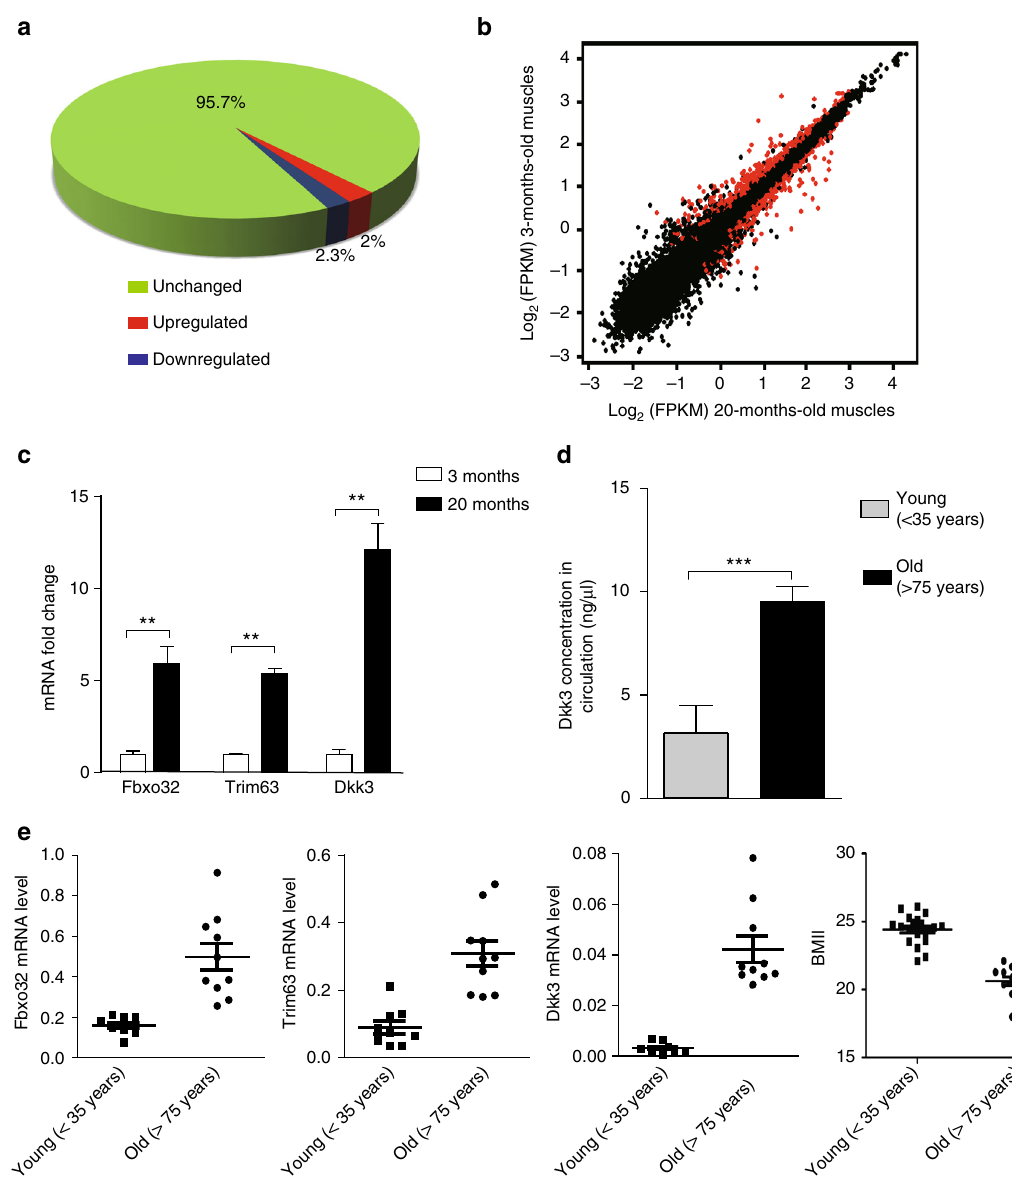
Fig. 1 Dkk3 is upregulated in muscles with age-related atrophy. a A pie diagram indicating the percentage of genes showing expression level changes in old versus young muscles. RNA was isolated from TA muscles showing atrophy and subjected for mRNA-sequencing analysis. The percentage of genes downregulated in TA muscles isolated from old mice compared to that in TA muscle isolated from young mice was indicated by blue. The percentage of genes upregulated in old TA muscles was indicated by red. The percentage of genes unchanged was indicated by green. b A scatter plot showing the comparison of transcriptome of old muscles showing atrophy versus young muscles. The red dots indicated the genes that were differentially expressed in old muscles versus young muscles. Statistic analysis was based on two independent mRNA-seq experiments for each sample. c Expression levels of Fbxo32 , Trim63 , and Dkk3 in primary myo fi bers isolated from young or old mice, respectively. RT-qPCR was performed with RNA extracted from the primary myo fi bers. Error bars indicated standard deviation (s.d.) and were based on three independent experiments. ** indicated p < 0.01. d Dkk3 protein level was elevated in peripheral blood of sarcopenia patients. Dkk3 protein level was examined by ELISA in blood samples taken from sarcopenia patients and healthy young humans. Error bars indicated s.d. and were based on 20 samples. *** indicated p < 0.001. e Dkk3 expression level was correlated with Fbxo32 and Trim63 expression level and BMI (body mass index) in aged human muscles. RT-qPCR assays were performed with muscle biopsies obtained from young or old patients and the results were normalized to GAPDH. The line indicated mean value. Error bars indicated s.d. and were based on 10 biological replicas. All p- values were based on two-tailed t- of myotubes remained unchanged, suggesting the thinner function extracellularly, recombinant Dkk3 was puri fi ed (Supple- myotubes are not due to differentiation defects (Supplementary mentary Fig. 5a) and added to the medium to treat myotubes Fig. 5d). These results indicate the occurrence of myotube differentiated from primary myoblasts. An irrelevant secreted atrophy. Consistently, both the mRNA and protein levels of protein (Fab) was used as control. Forty-eight hours after Dkk3 Fbxo32 and Trim63 were signi fi cantly upregulated upon extra- treatment, the myotubes became signi fi cantly thinner than those cellular Dkk3 treatment (Supplementary Fig. 5e, f). Together, in the control group (Supplementary Fig. 5b, c). The fusion index